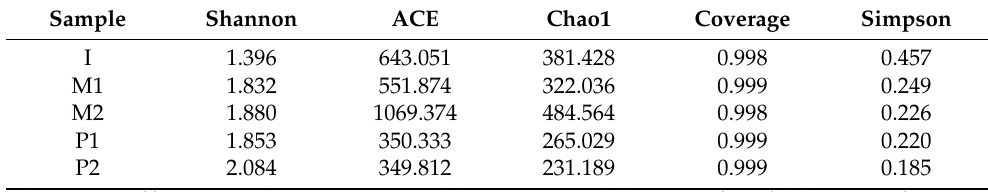
Table 4. Alpha diversity index of the magnetite and pyrite systems during Cr (VI)